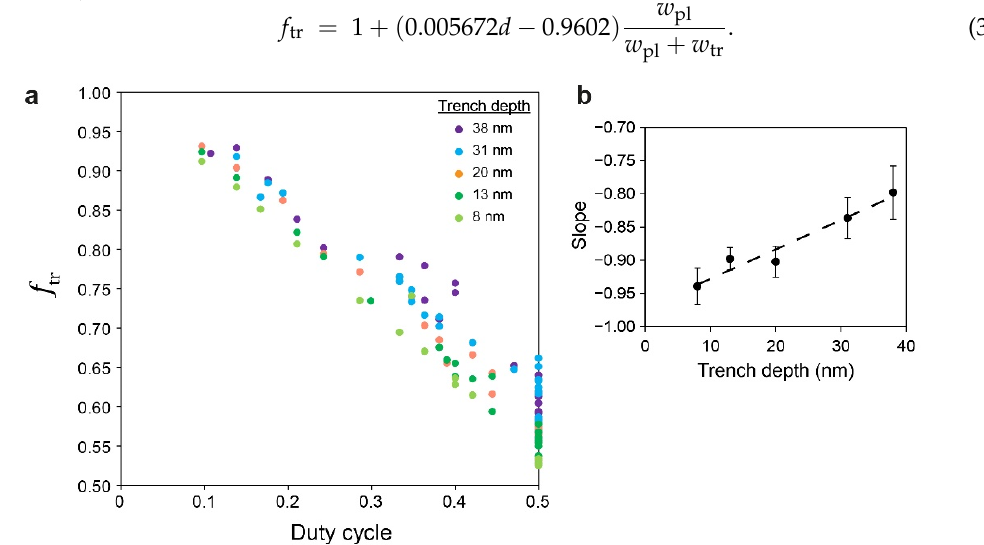
Figure 10. ( a ) Dependence of fraction of BCP in the trench on the duty cycle (see Supplementary Figure S3 for the separate curves). ( b ) Dependence of the slopes of the data in ( a ) on trench depth.